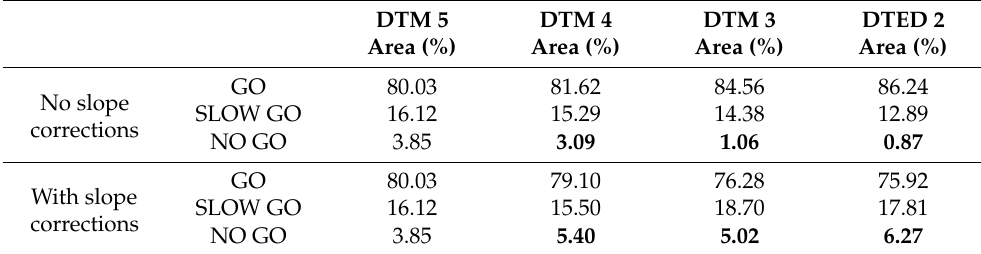
Table 8. The comparison of the extent of passable, hardly passable, and impassable areas with different elevation models without slope corrections and with slope corrections. Location: Doln í Morava, 3 km × 3 km, arid conditions, GO max slope = 20 ◦ , SLOW GO max slope = 30 ◦ . The main improvements in the results are displayed as bold values.